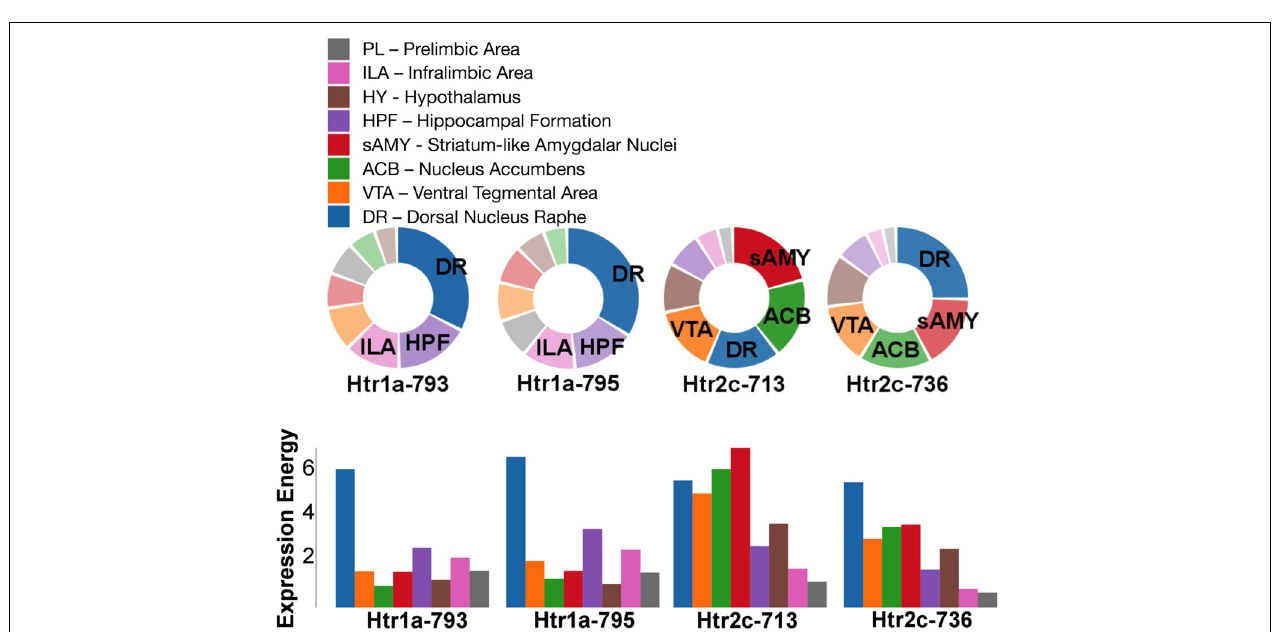
FIGURE 6 | ABADV Pie and Bar Chart of Serotonin Receptor Genes in Brain Structures Associated with Reward Processing. (Top) Each pie represents a different gene expression experiment, while the slices within a pie represents a different brain structure. Opacity of each pie slice denotes the amount of expression energy relative to other genes. Size of pie slice